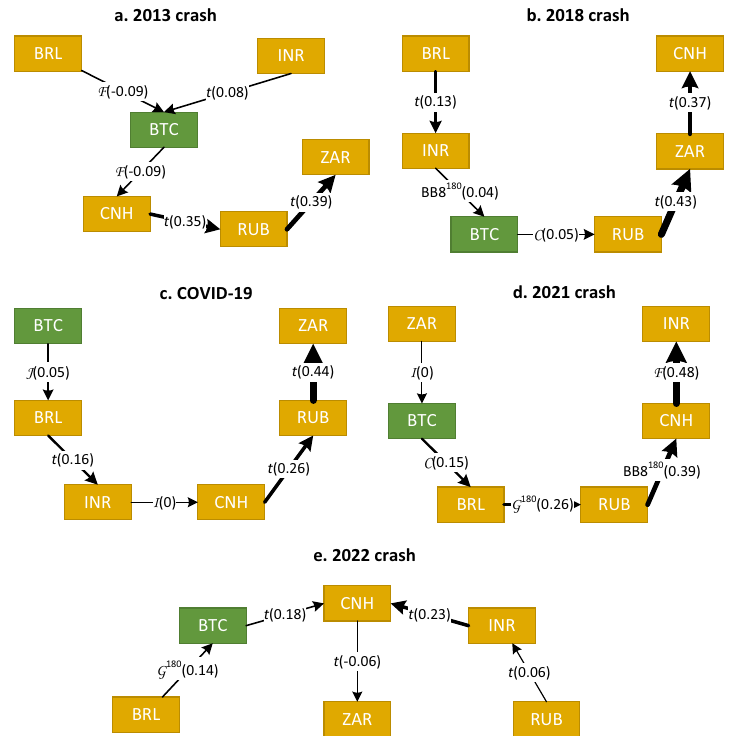
Fig. 7 Estimated R-vine copulas (first trees) for BRICS basket during five Bitcoin crashes. The direction of the dependence transmission path is characterized by an arrow that indicates the pair copula and Kendall’s τ in parentheses. The strength of the dependence is illustrated with the thickness of the